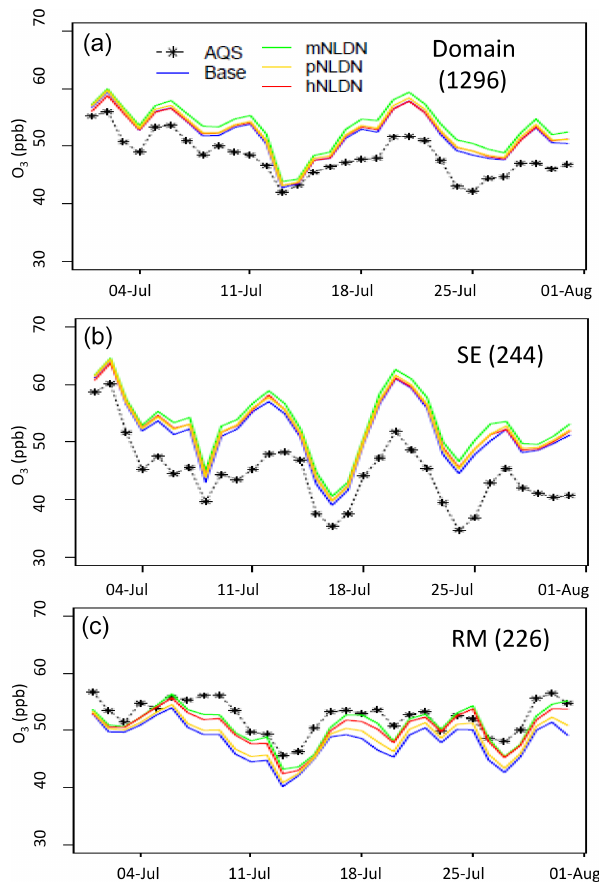
Figure 3. Time series of daily mean NO x over the domain (a) , SE (b) , and RM (c) in July 2011. The numbers in the parentheses fol- lowing the region names are the number of AQS